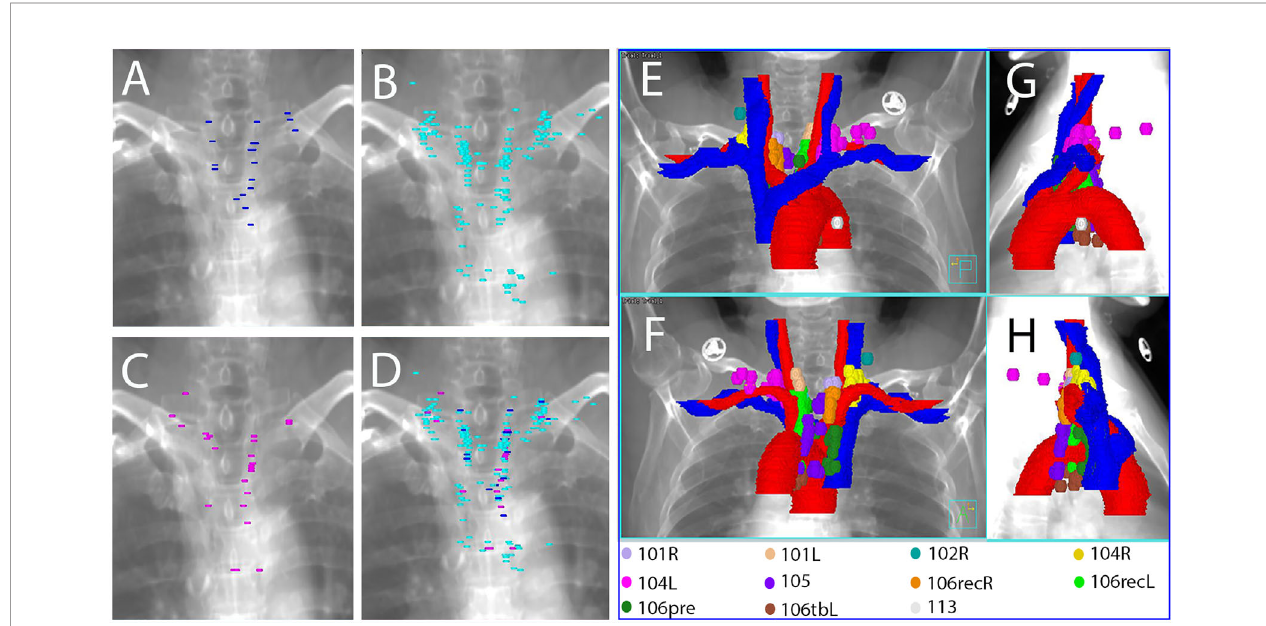
FIGURE 2 | Reconstructed images with all of the plotted LNs (A – D) and all of the TVnds (E – H) on the template CT. (A) anterior-posterior viewpoint for upper TESCCs; (B) anterior-posterior viewpoint for middle TESCCs; (C) anterior-posterior viewpoint for lower TESCCs; (D) anterior-posterior viewpoint for all TESCCs; (E) anterior-posterior viewpoint for all TESCC; (F) posterior-anterior viewpoint for all TESCCs; (G) right-left viewpoint for all TESCCs; (H) left-right viewpoint for all